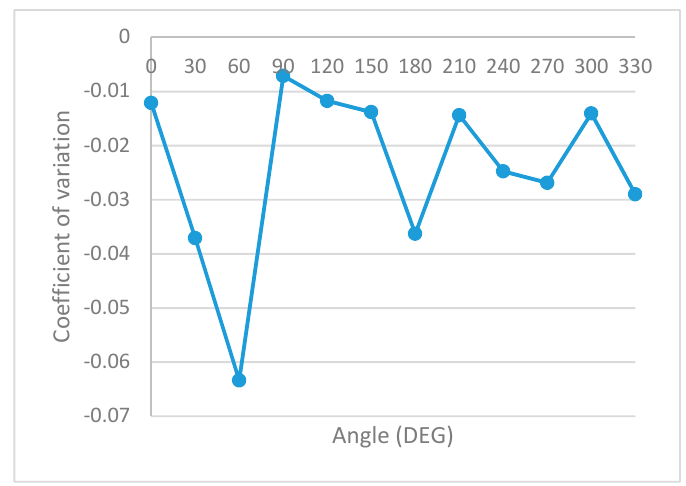
Figure 25. Statistical analysis. Coefficient of variation of RSSI measurements.